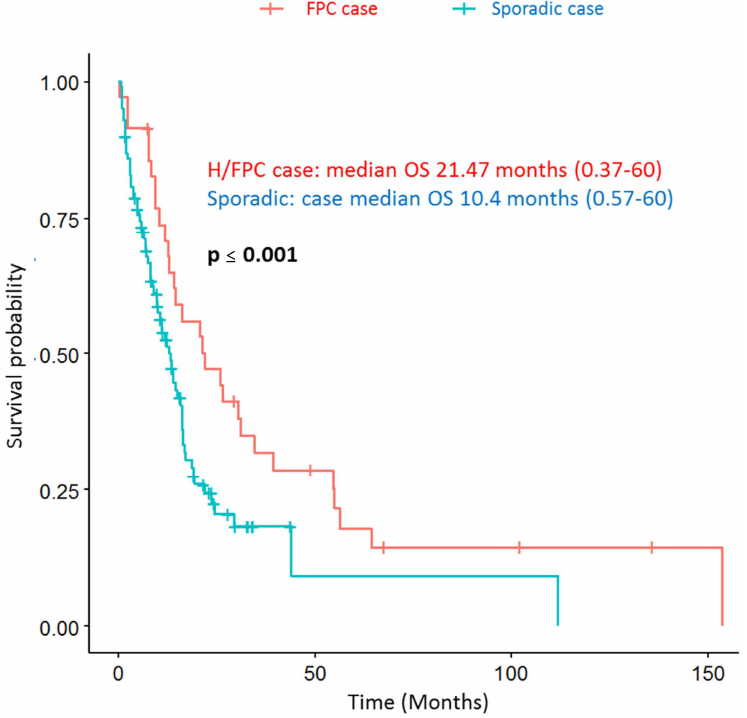
Figure 4. Hereditary or familial PDAC cases have a longer overall survival (OS) compared to sporadic